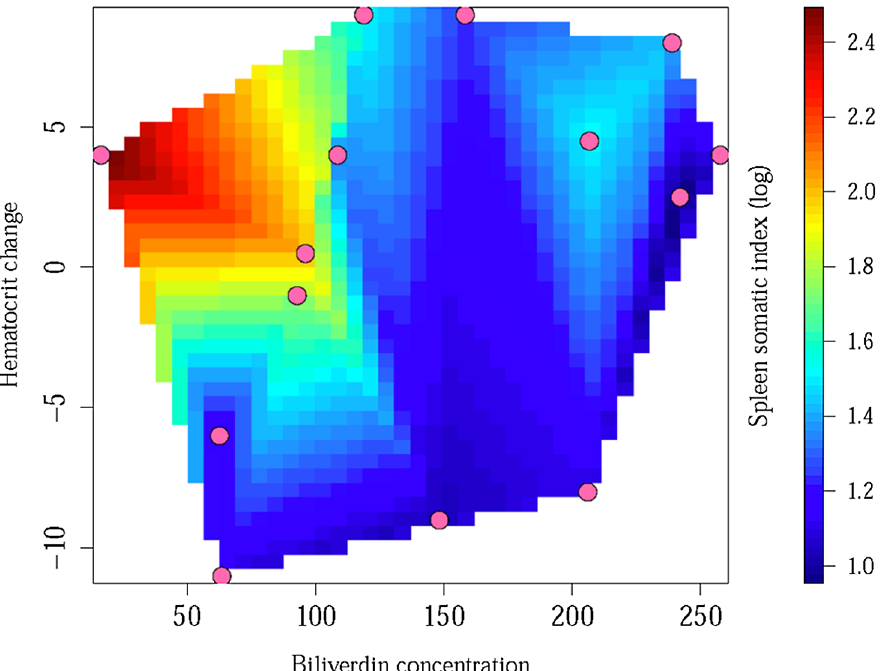
Fig 2. Variation in spleen size, hematocrit, and biliverdin concentration. Relative spleen size (indicated by the color legend on the right) was related to changes in hematocrit (y-axis) and biliverdin concentrations in bile (x-axis). Specifically, relatively larger spleens were associated with increases in hematocrit and lower concentrations of biliverdin in bile, regardless of treatment. Together, biliverdin concentration and hematocrit change explained 45% of the variation in relative spleen size (Adj-R 2 =